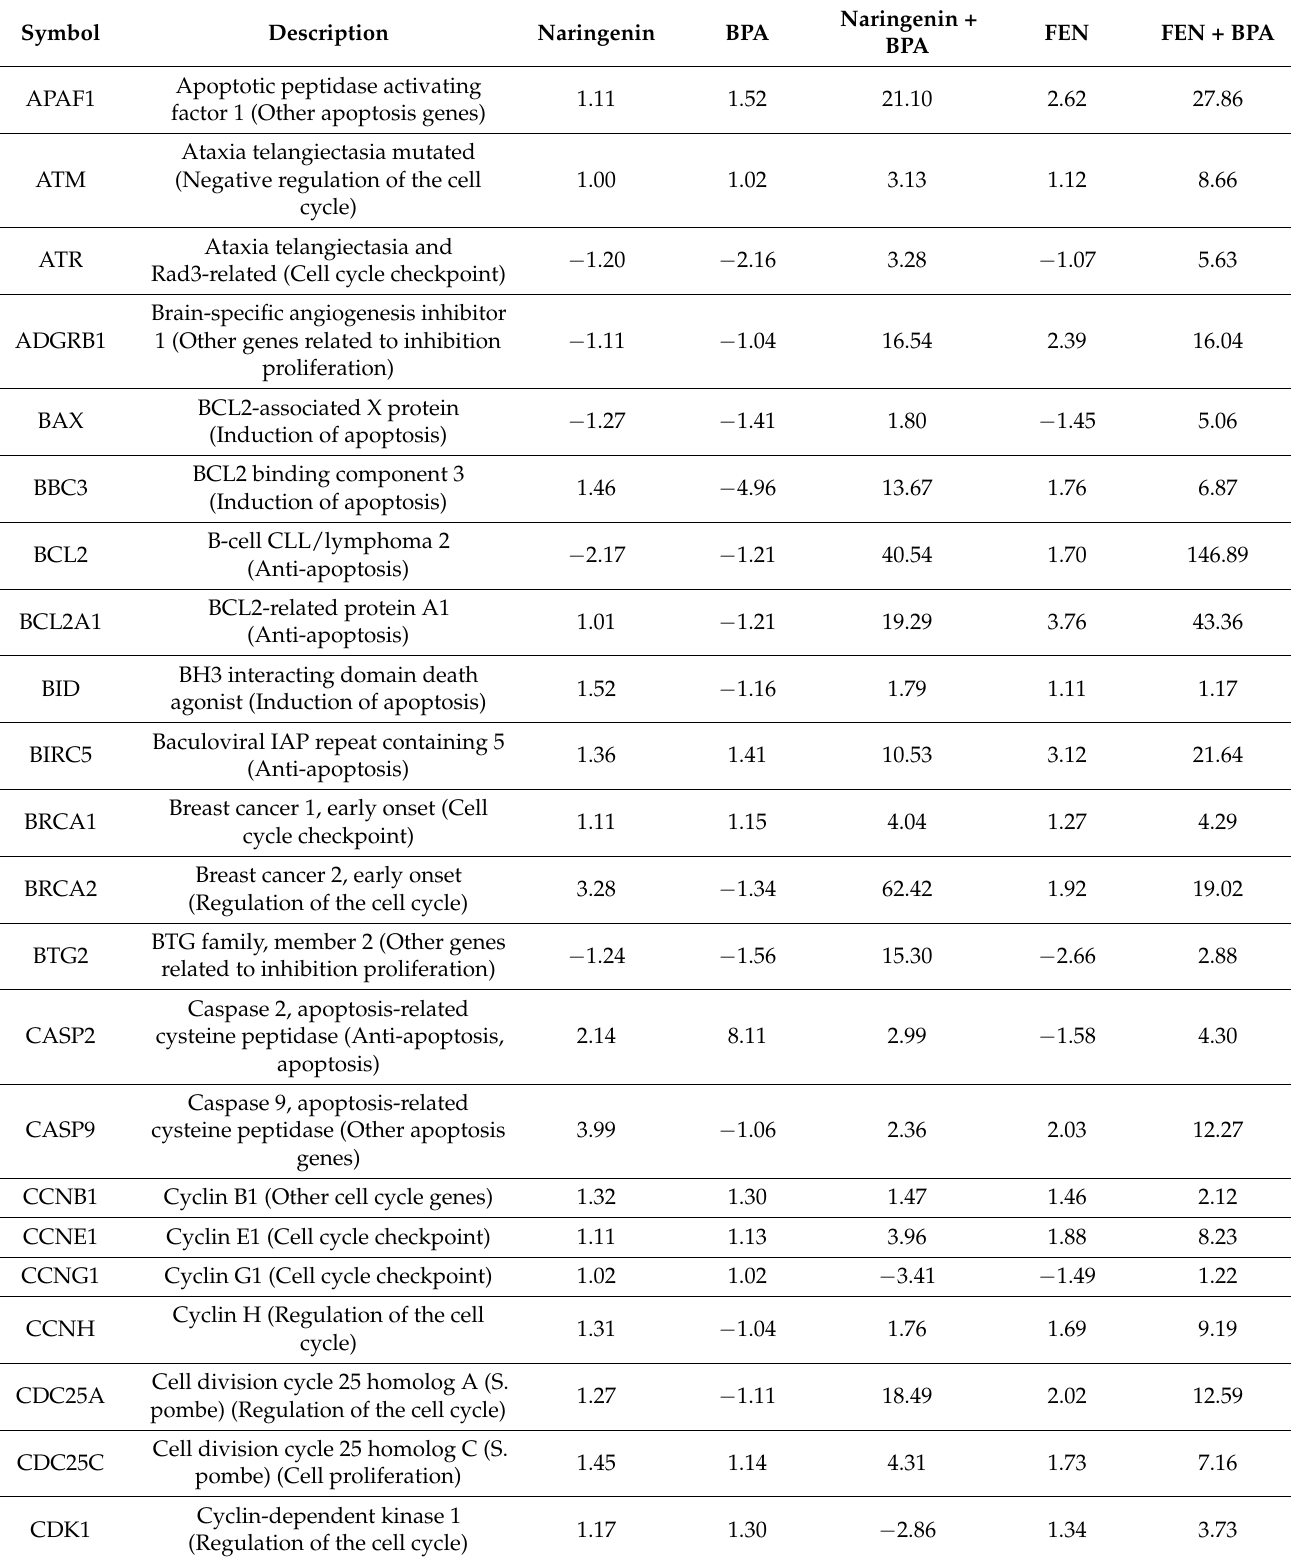
Table 3. Fold-change in the expression levels of related genes to the p53 signaling cascade in